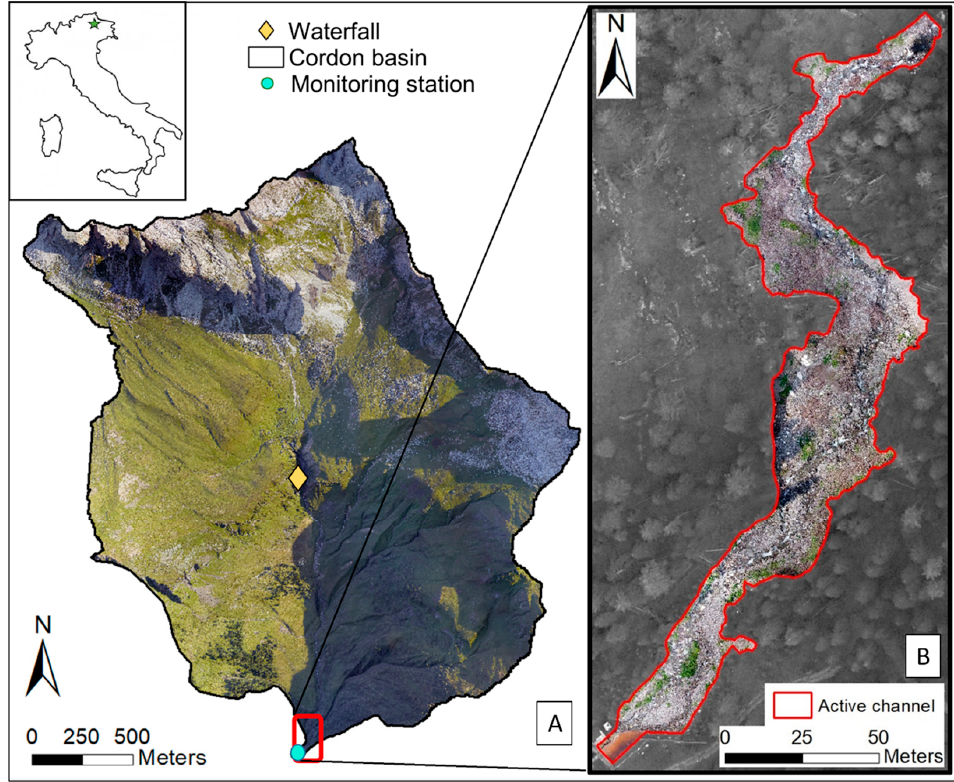
Figure 1. ( A ) Aerial picture of the Rio Cordon basin located in the northeast of Italy (green pentacle), the red square at the outlet of the basin represents the area where the UAV survey was made along the ( B ) study reach. In this part, the planimetric and step–pool analyses were made. Being part of the Southern Limestone Alps, the substrate of the Rio cordon is charac- [25]. As the range of elevation goes from 1763 to 2763 m a.s.l., the vegetation cover is lim- ( Larix decidua ). Bare rocks (14%), shrubs (18%), and grasslands (61%), instead, cover the rest of the area. The Rio Cordon main channel (hereinafter Rio Cordon) is characterized